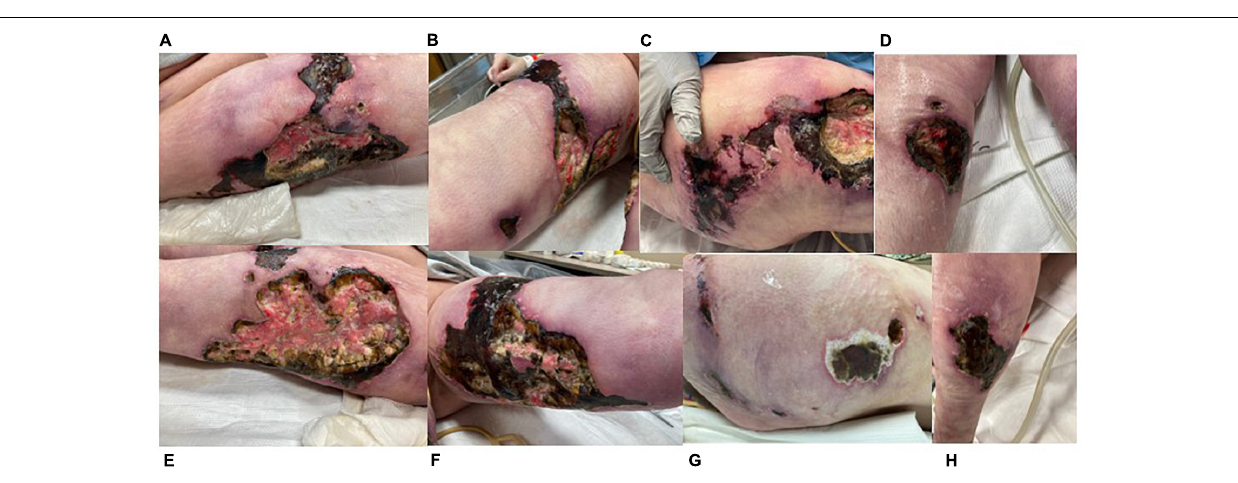
FIGURE 4 | Images of progressive necrotic ulcers taken 11/30/21 (other than C). (A) Right lateral thigh. (B) Right medial thigh. (C) Right flank (11/23/21). (D) Right anterior lower leg. (E) Left lateral thigh. (F) Left medial thigh. (G) Left flank. (H) Left posterior lower leg. Lesions not shown: right posterior lower leg, left anterior lower